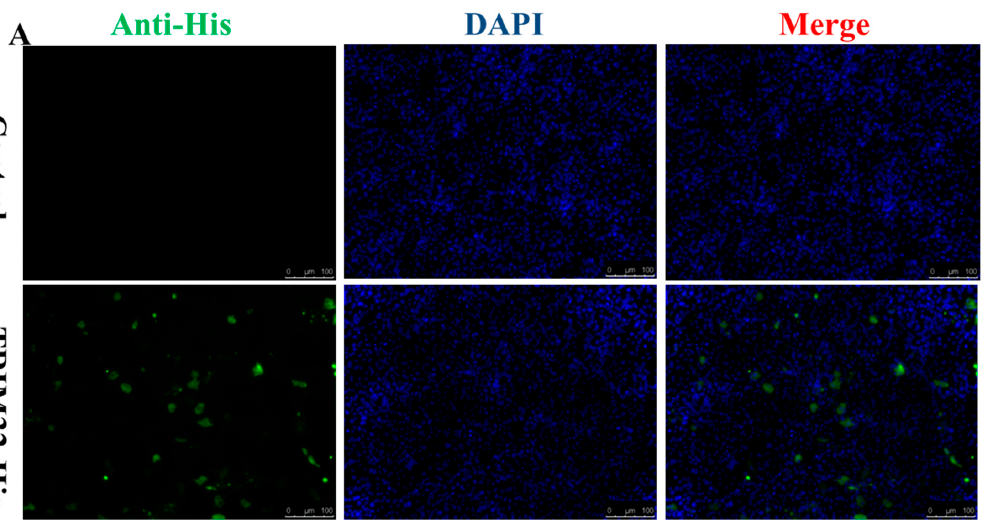
Figure 4. ( A ) Hemorrhagic symptoms appeared at day 5 post infection with SVCV compared with the fish in control group that did not show any symptom; ( B – D ) Relative expression patterns of common carp TRIM32, type 1 interferon (IFN1), and spring viraemia of carp virus glycoprotein G (SVCV-G) gene after SVCV infection, respectively. TBP was used as the internal control, the results were normalized basing on that of the carp at day 0 (for TRIM32 and IFN1) and the carp 1 day (for SVCV-G) after SVCV infection. Data presented here represent mean values from three independent experiments and error bars denote the standard deviation. The significant values (0.01 < p < 0.05 and p < 0.001) to the control group was noted with * and ***, respectively.